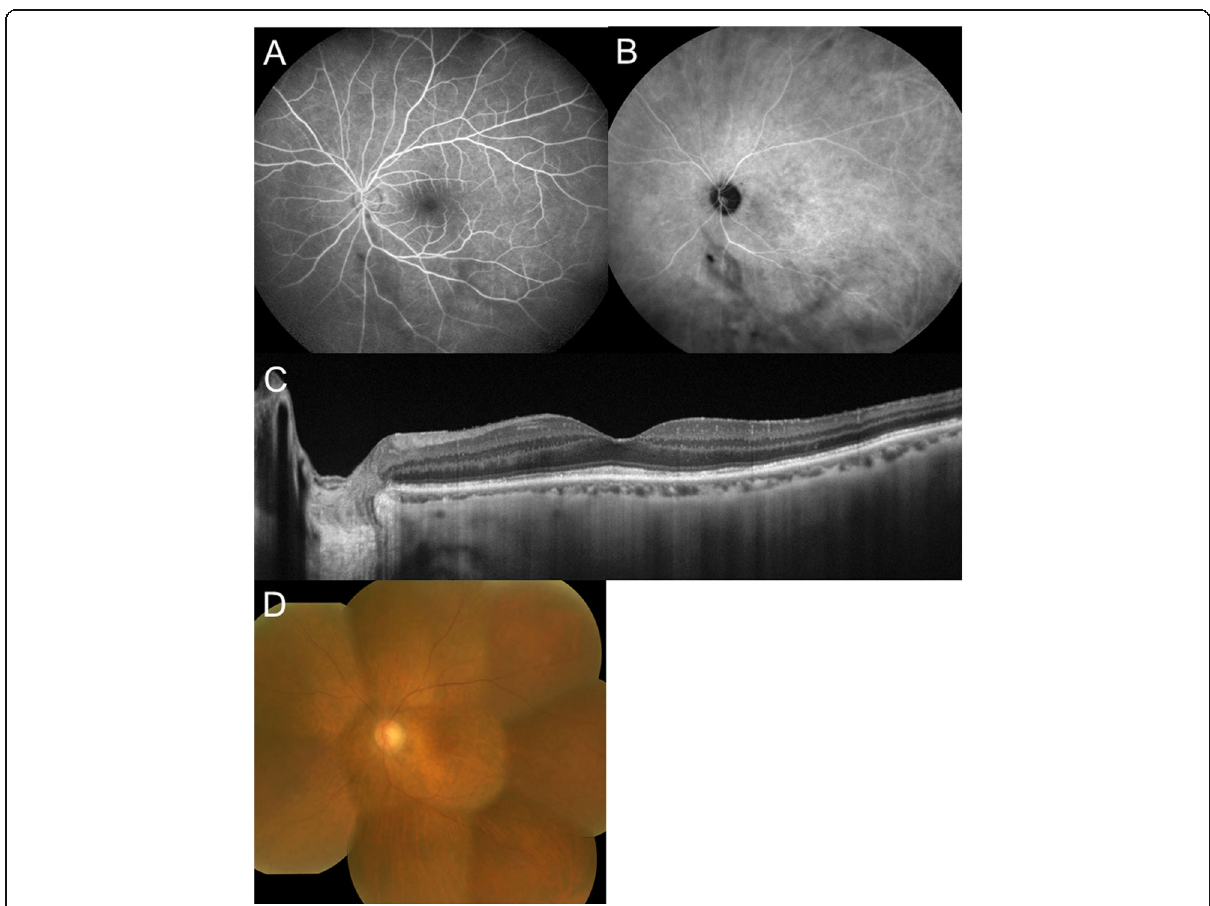
Fig. 2 Findings of the left eye 2 weeks ( a, b ) and 3 weeks ( c, d ) after the first visit in the present case. a On FA 2 min. after the dye injection, hyperfluorecence observed at the initial visit disappeared. b On ICGA 16.5 min. after the dye injection, numerous hypofluorescent dots regressed. c EDI-OCT revealed the recovery of macular ellipsoid zone and absorption of hyper-reflective foci. d Color fundus photography showed resolution of the white dots with no chorioretinal